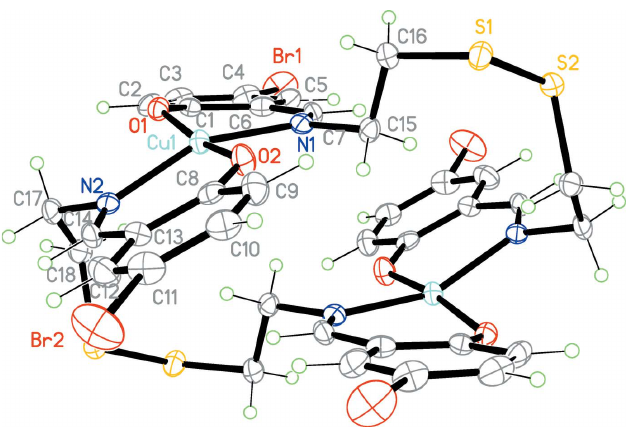
Figure 1 The molecular structure of the binuclear complex unit of the title compound, showing 50% probability displacement ellipsoids. Unlabelled atoms are related to labelled ones by the symmetry operation (2 (cid:3) x , (cid:3) y , 2 (cid:3) z